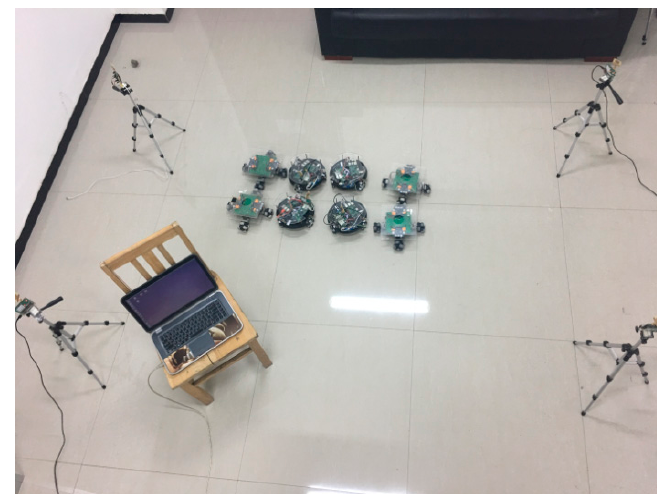
Figure 7. Multi-robot research platform.